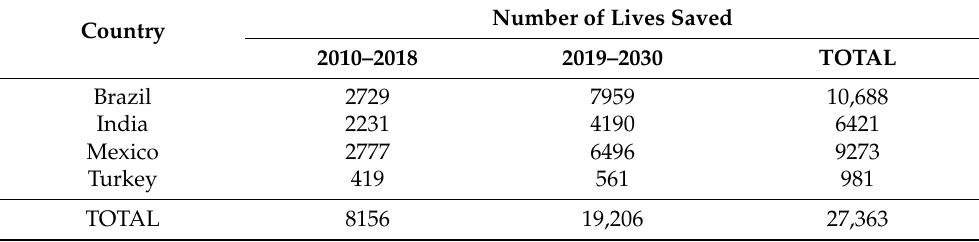
Table A5. Estimates of Lives saved from the Implementation of Bus Rapid-Transit Projects and Other